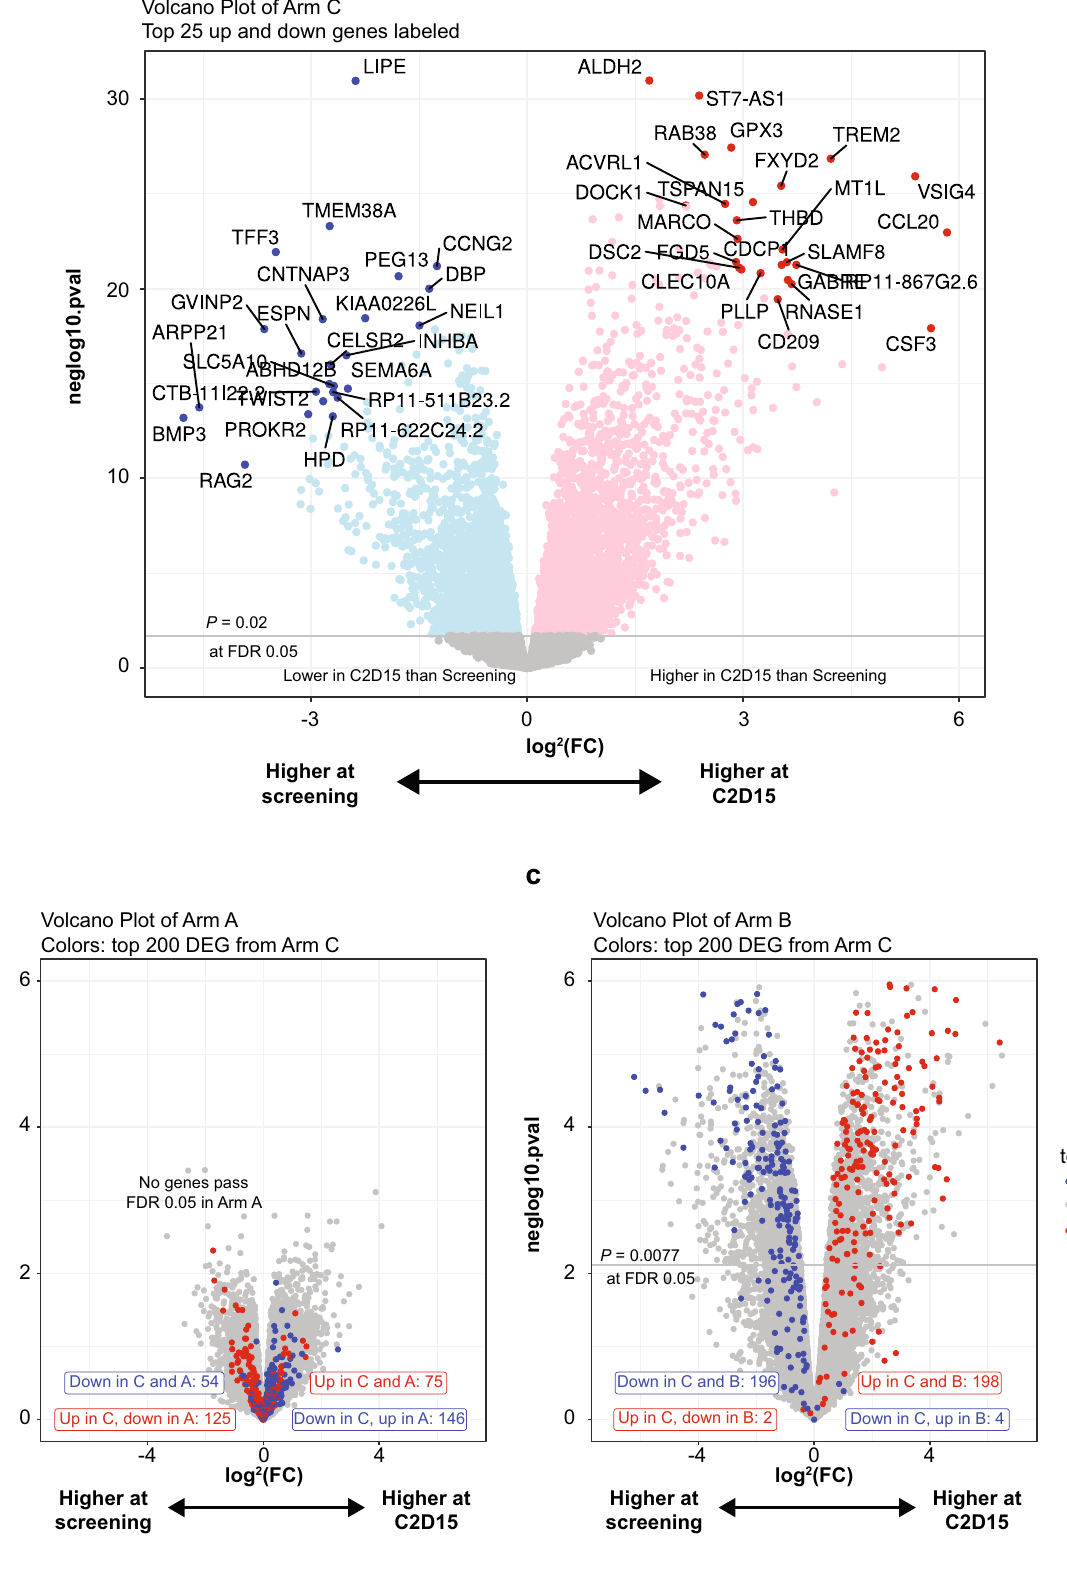
Volcano Plot of Arm C Top 25 up and down genes labeled